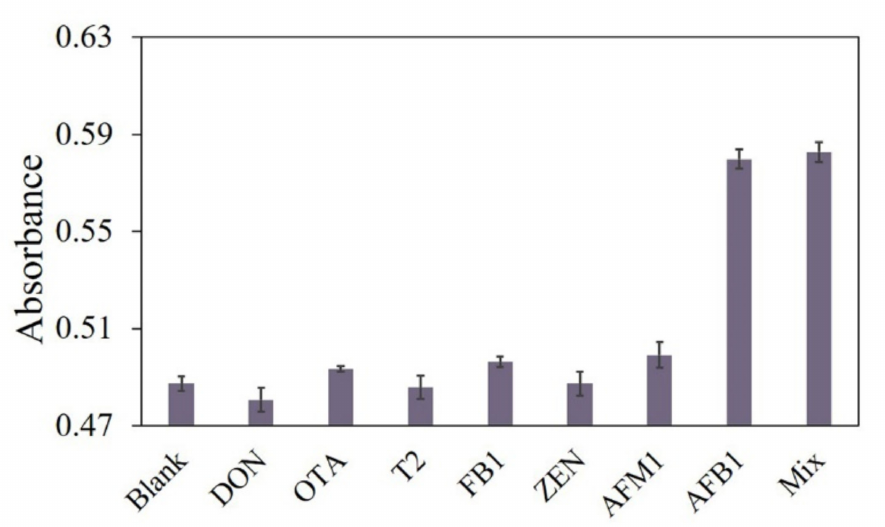
Figure 6. Selectivity investigation of the proposed sensor for DON, OTA, T2, FB1, ZEN, and AFM1 (final concentration 100 ng/mL). The concentration of AFB1 is 10